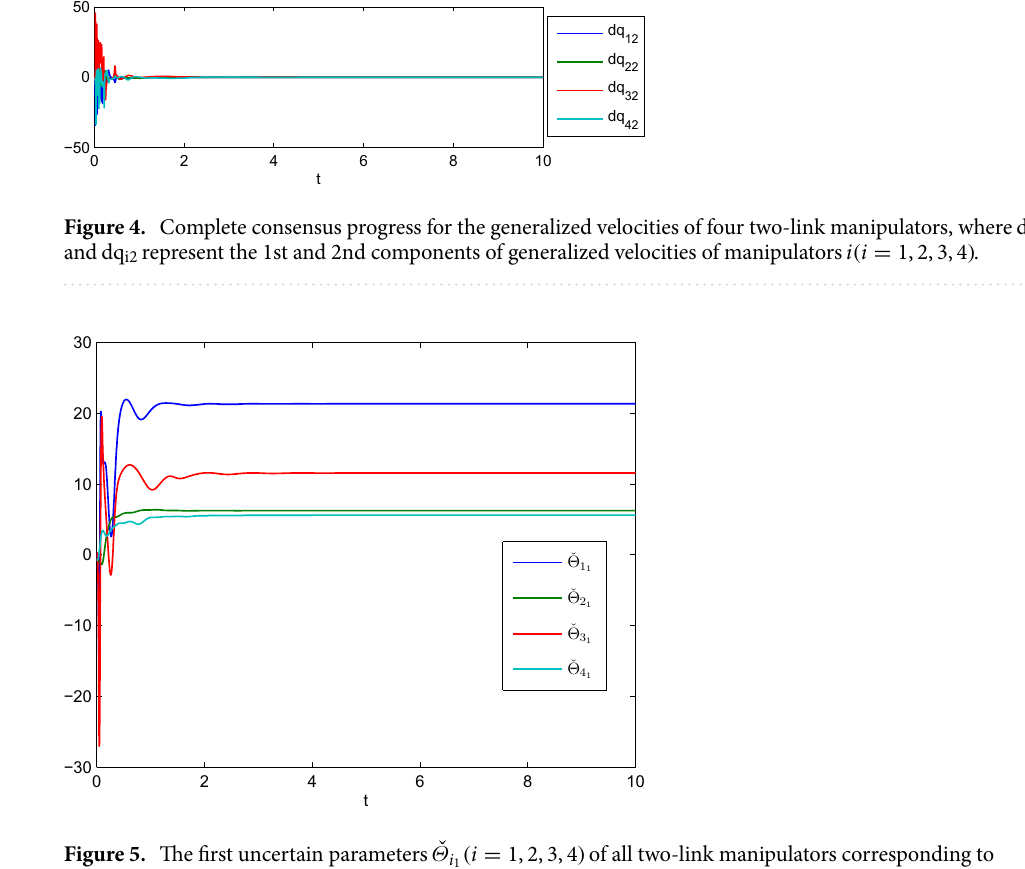
Figure 5. The first uncertain parameters Figs. 3,